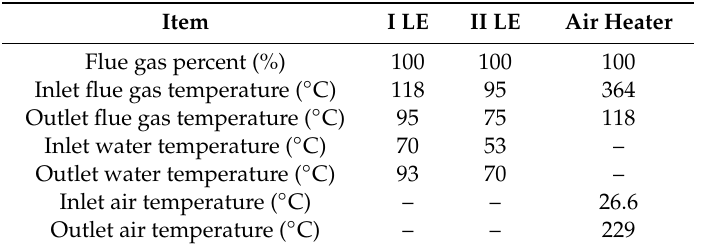
Table 3. Thermal parameters of heat exchange equipment at the tail of the boiler.